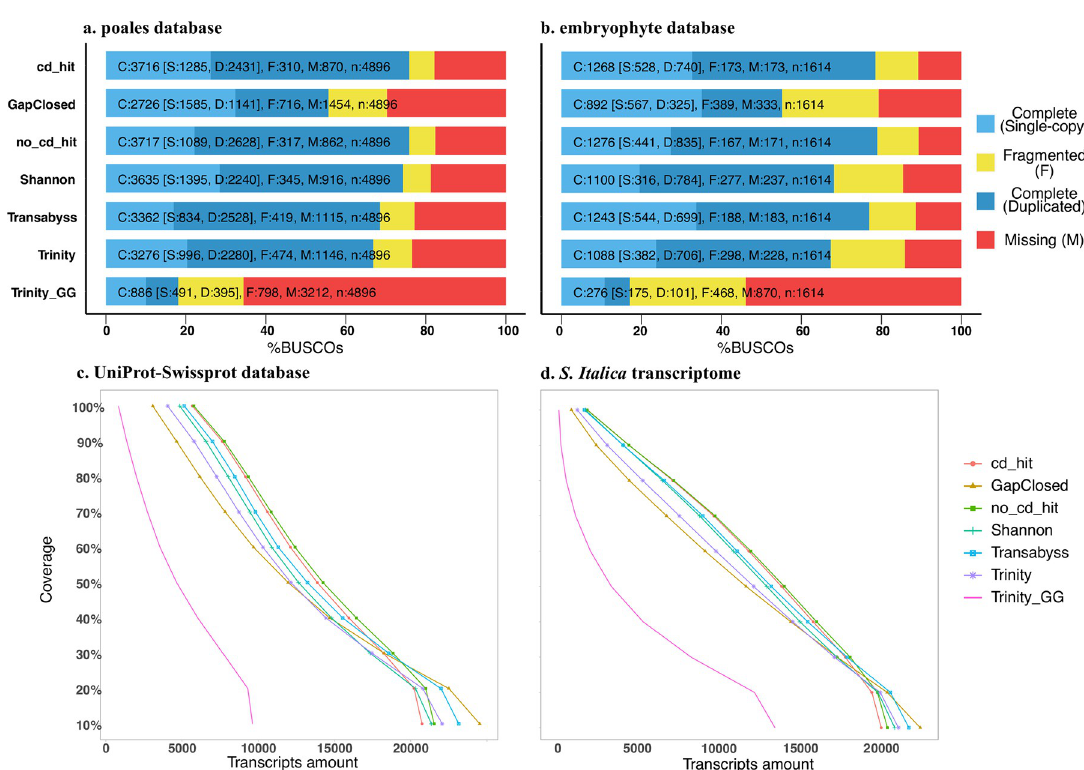
Fig 2. Quality assessments for seven constructed transcriptome assemblies. a and b. cumulative percentage of orthologues identified from the BUSCO search from two databases a. poales (n: 4,896) and b. embryophytes (n: 1,614) against the seven constructed transcriptome assemblies. Complete orthologue (C) can be either single-copy (S) or duplicated (D). Incomplete orthologues are considered fragmented (F). If orthologues from the database are not identified, they are marked as missing (M); c and d. the cumulative number of transcripts along with alignment coverage changes to annotated genes from two databases c. Uniprot-Swissprot and d. S . italica v2.2 transcriptome sequence file against the seven constructed transcriptome